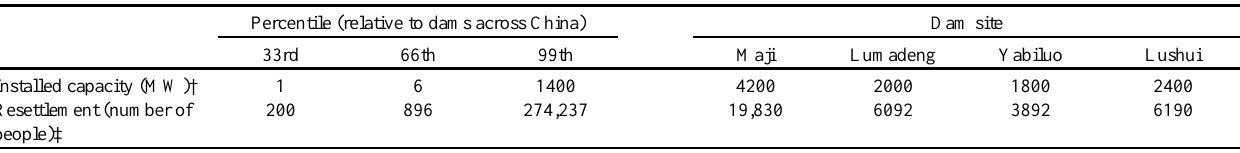
Table 2. Projected hydroelectric capacity and number of people that would need resettlement for four proposed hydroelectric dams on the Nu River, China, relative to established dams throughout